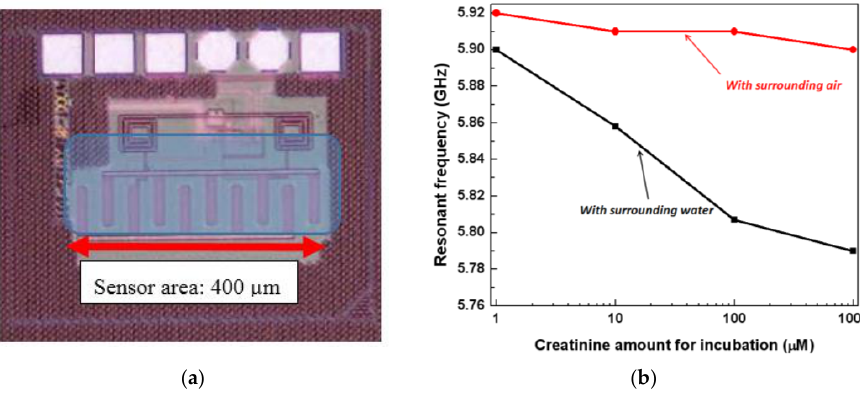
Figure 9. ( a ) The immunosensor chip with the capacitor exposed for biomolecule immobilization; ( b ) Frequency shift of the oscillator for different concentration of creatinine [51].